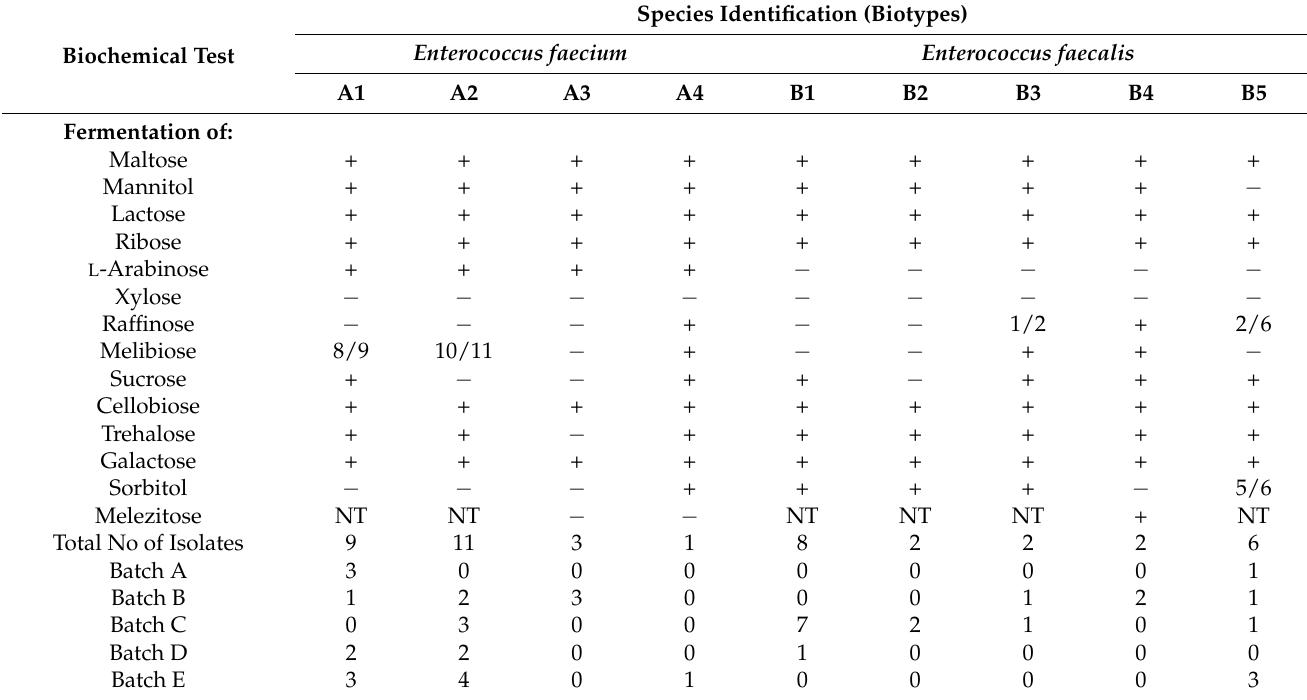
Table 4. Biochemical characterization of 44 Enterococcus spp. isolates from five retail RTE Galotyri-like acid-curd cheese batches and their numerical distribution in each cheese